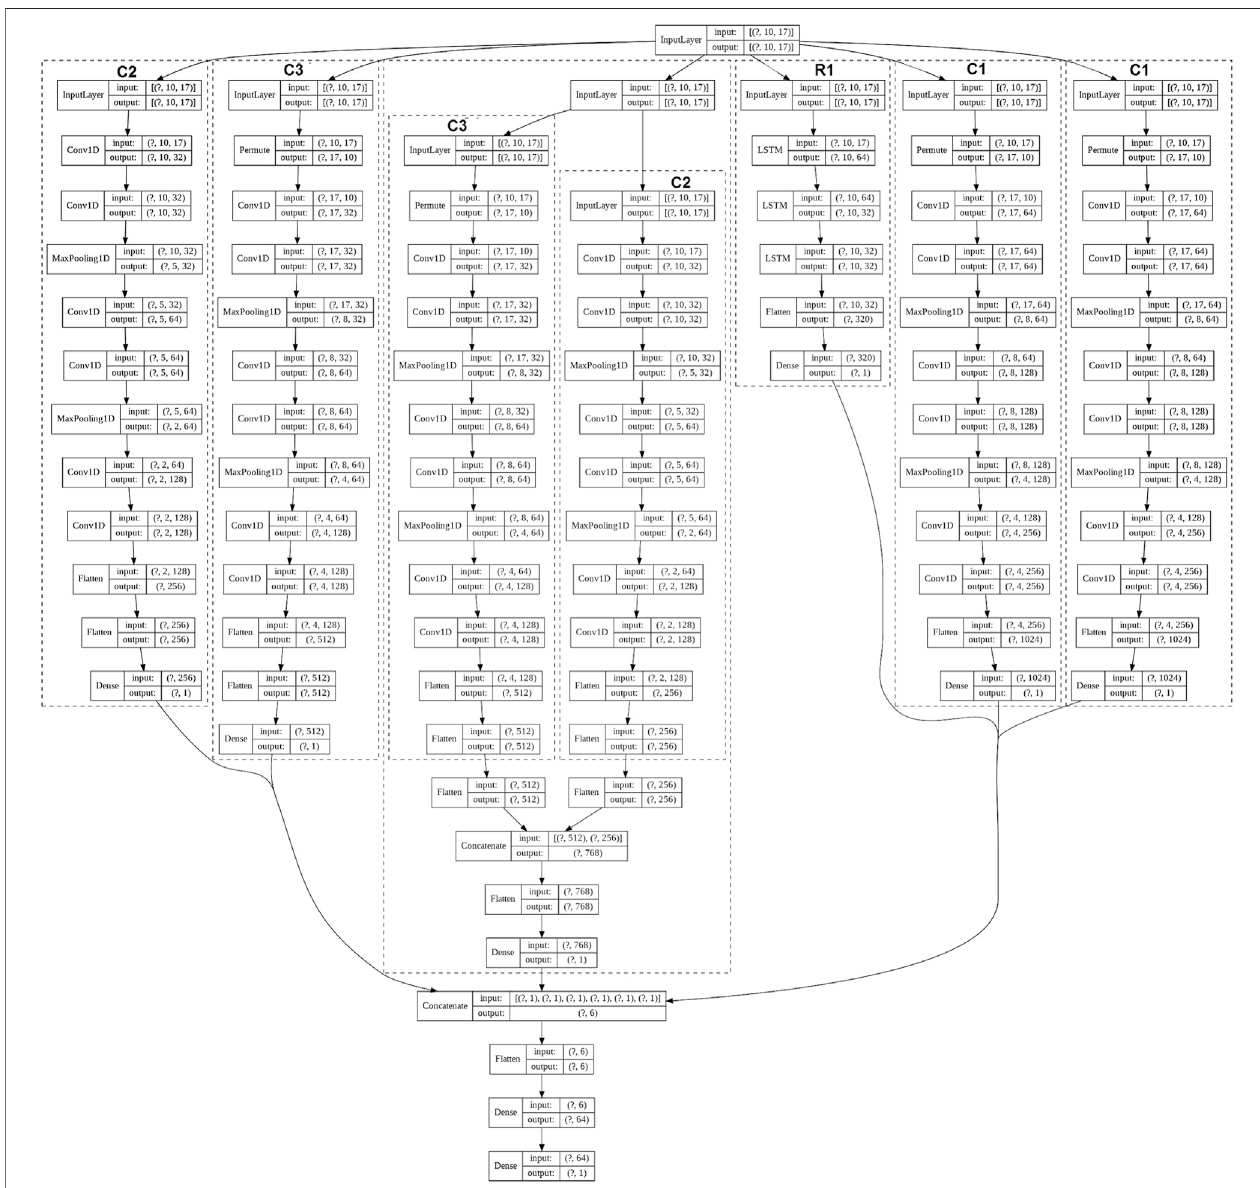
FIGURE 6 | Neural networks training process on cross-validated